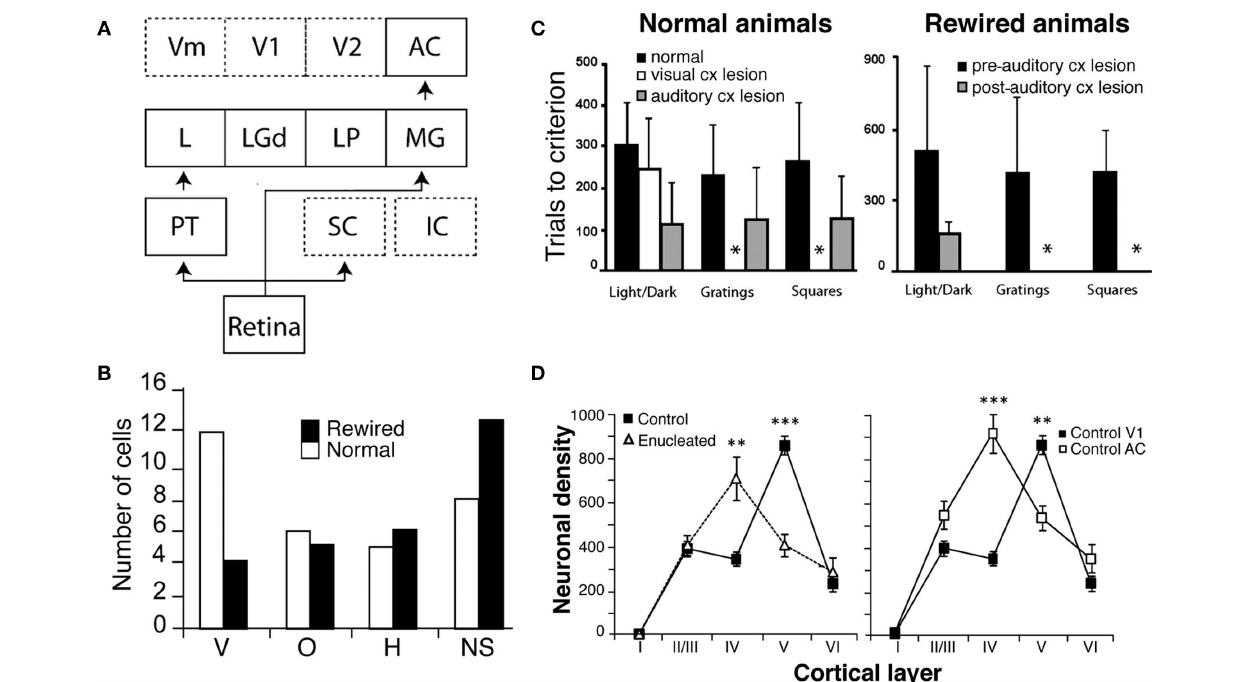
(C) Rewired hamsters learn visual discrimination tasks as well as normal animals. In normal animals, a bilateral V1 lesion abolishes pattern discrimination. The same result is obtained with a lesion of the auditory cortex in rewired animals (shown by the asterisks). (D) Neuronal density of parvalbumin-immunoreactive cells (PV-Ir) within layers of the auditory and visual cortices in normal and enucleated hamsters. In V1 of control animals, PV-Ir are mainly found in layer V and in lesser density in layer IV. Following enucleation, the density of PV-Ir neurons is now greater in layer IV than the controls. This contrasts with the lower density of PV-Ir neurons in layer V. The resulting pattern of laminar distribution of PV-Ir cells in the primary visual cortex resembles that of the primary auditory cortex (adapted from Ptito et al., 2001a; Ptito and Desgent, 2006; Desgent et al.,